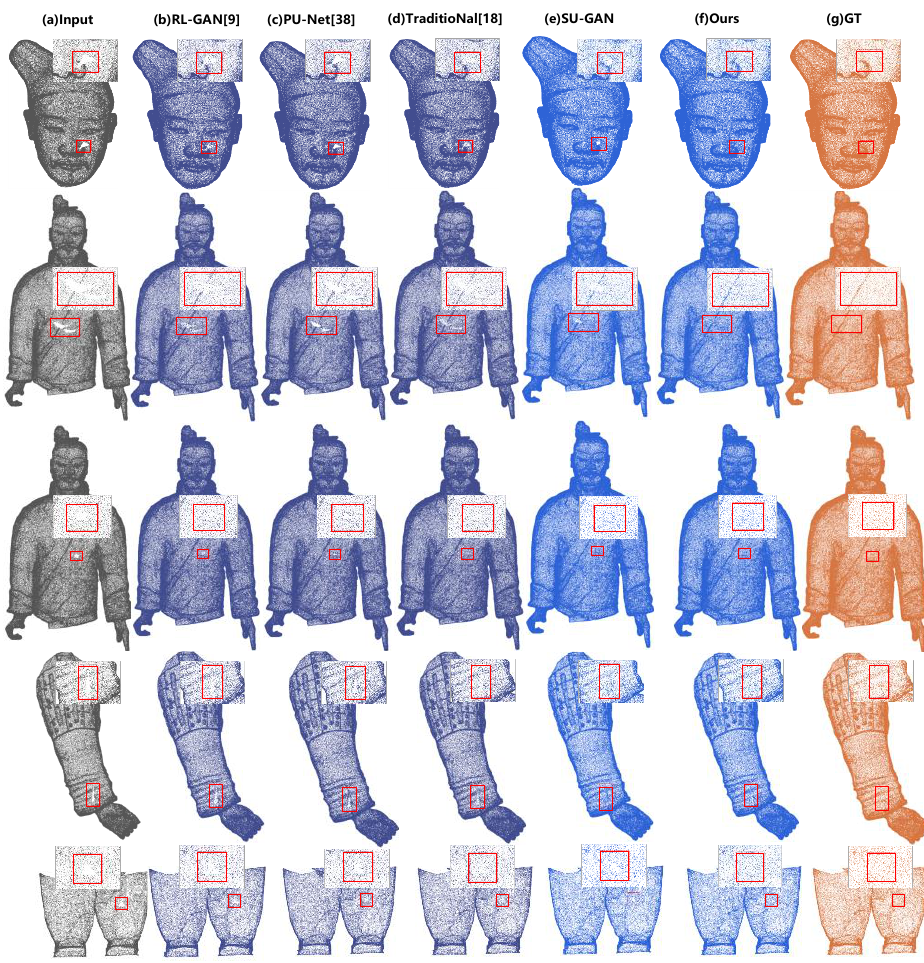
Figure 10. The comparison of completion results between other methods ( b – d ), our SU-GAN ( e ), and MU-GAN ( f ) from inputs ( a ). The input of all methods is a point cloud patch containing